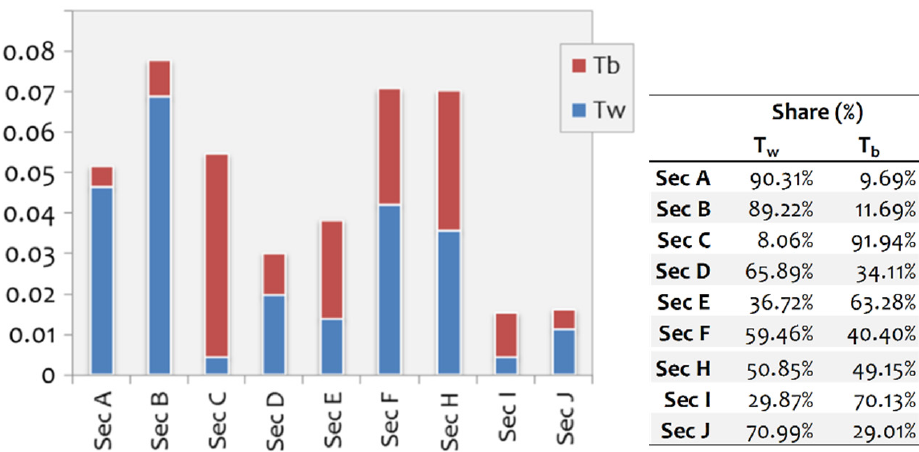
Figure 7. Stacked bars showing the contribution of each component ( T w , T b ) to the configuration of the Theil index, per sector (annual grouping), where the measures’ computations were applied to GVA (pLU) data. GVA prices are measured in EUR/LU (constant prices on 2008 basis). At the final part of the analysis, the available GVA (pLU) scores are analyzed by using a shift-share analysis, aiming to interpret the variability of the GVA (pLU) changes in terms of the spatio-economic structure of the available data. By computing the shift-share components N ir ( t , t + 1), M ir ( t , t + 1), and S ir ( t , t + 1), for all available regions r = 1, . . . ,